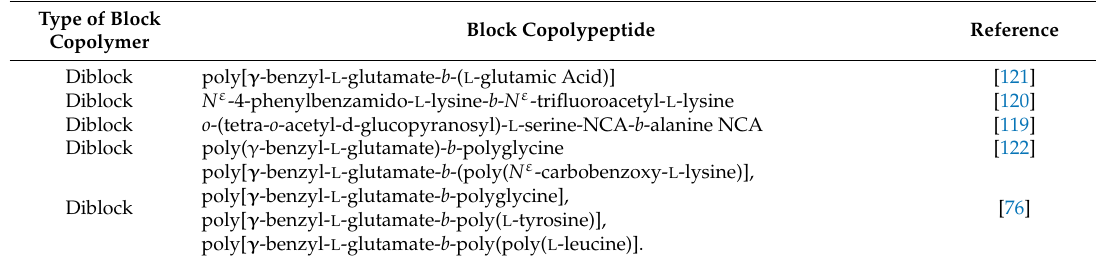
Table 3. Illustrative examples of block copolypeptides reported in the literature.